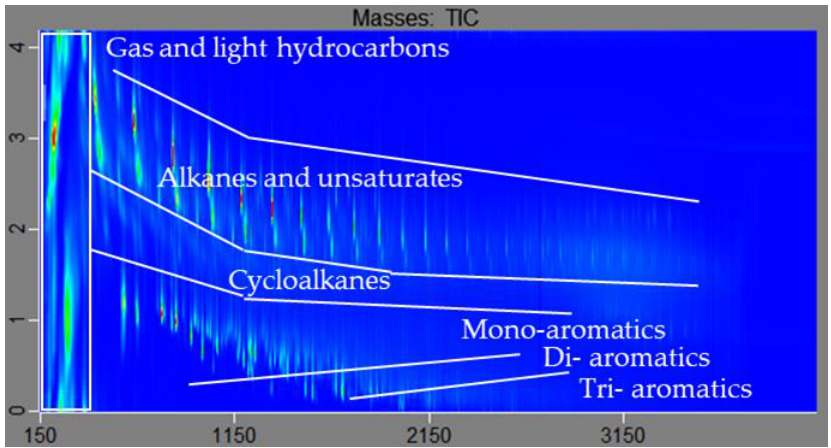
Figure 2. An example of processing a two-dimensional TIC chromatogram for the calculation of organic compound class distribution in pyro-GCxGC-FID/TOFMS.